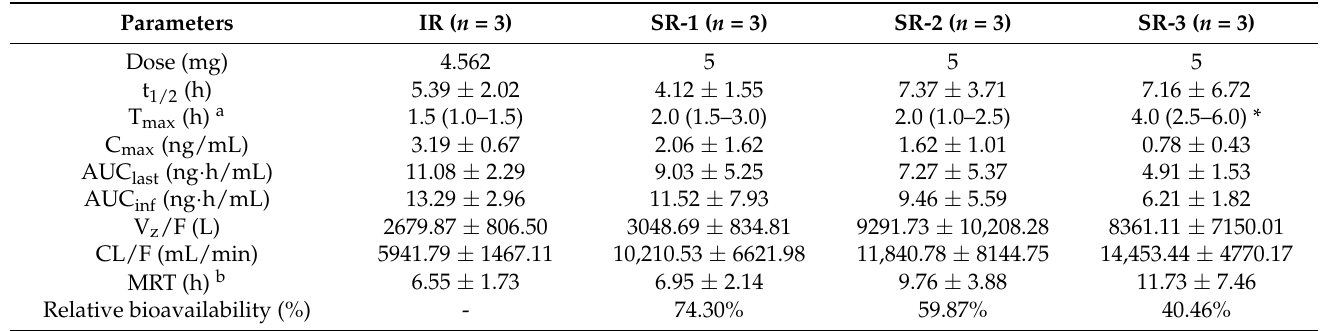
Figure 3. The average plasma concentration-time profiles of donepezil after the oral administration of ( A ) the reference IR tablet (as donepezil 4.562 mg, n = 3) and ( B ) SR-1, SR-2, and SR-3 (as donepezil 5 mg) (n = 3, each) in Beagle dogs. Table 3. The non-compartmental pharmacokinetic parameters (mean ± S.D.) of donepezil after the oral administration of donepezil IR and SR formulations in Beagle